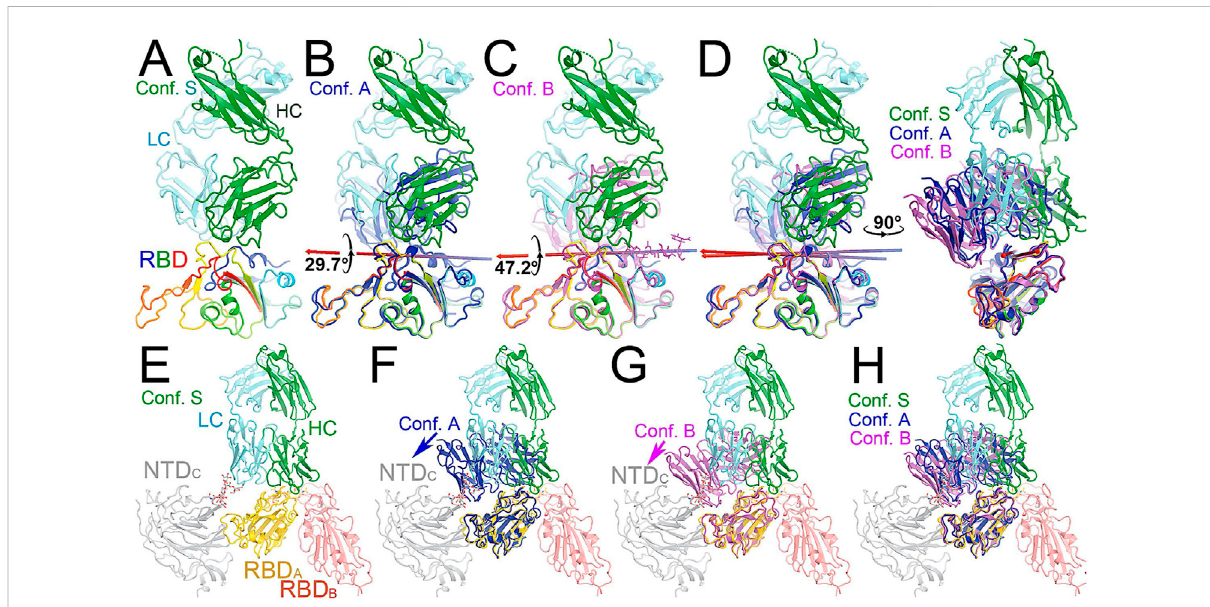
FIGURE 3 Comparison of MD-derived conformation A (blue) and B (magenta) with the starting conformation S (multicolor). (A) Starting conformation S. (B) SuperpositionbetweenconformationsSand(A). (C) SuperpositionbetweenconformationsSand(B). (D) Twoorthogonalviewsofconformations S,Aand(B). (E) ConformationSincontextofthespiketrimerwithNTDandRBDofneighboringsubunitsincluded. (F) Superpositionofconformations SandAinthecontextofthespikeprotein. (G) SuperpositionofconformationsSandBinthetrimer. (H) CompiledviewofconformationSandA/ B in the trimer.